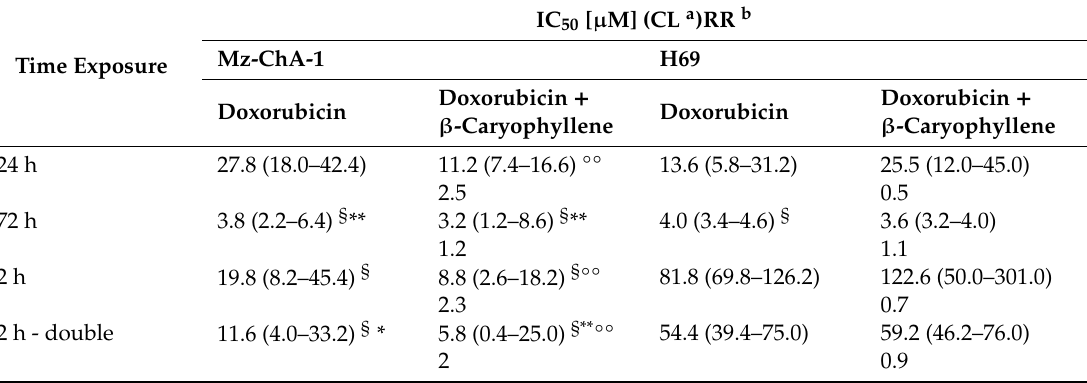
Table 2. IC 50 values of β -caryophyllene under both long-term and metronomic schedules in Mz-ChA- 1 and H69 cells. In the last protocol, the cells were subjected to a short and/or repeated exposure of 2 h to the test substances followed by a recovery time of 72 h. Data represent the mean ± SE (standard error) of at least two experiments in which each treatment was tested in triplicate (n = 6).